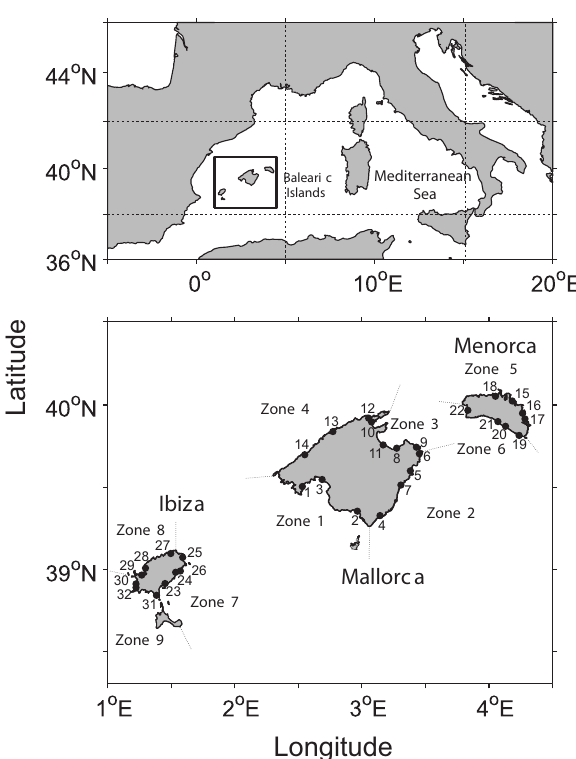
F IG . 1. – Map of the Balearics showing the locations of the sampling sites and the zone divisions used for this study.